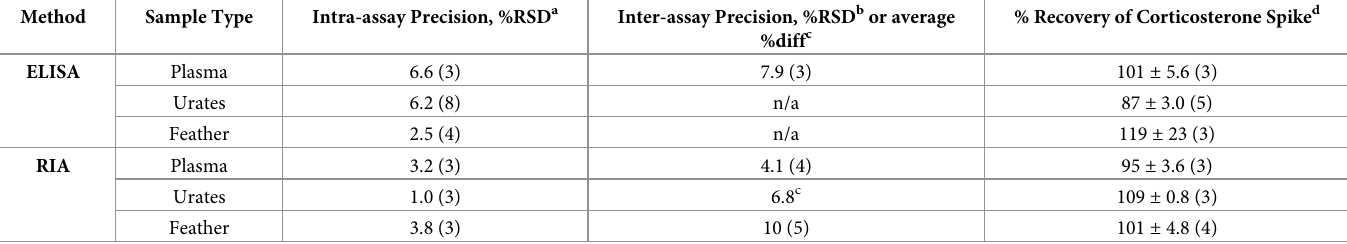
Table 1. Precision and accuracy of enzyme-linked immunosorbent assay (ELISA) and radioimmunoassay (RIA) measurements of condor plasma, urate extract, and feather extract. All samples were run in duplicate and the number of samples analyzed in is in parentheses.